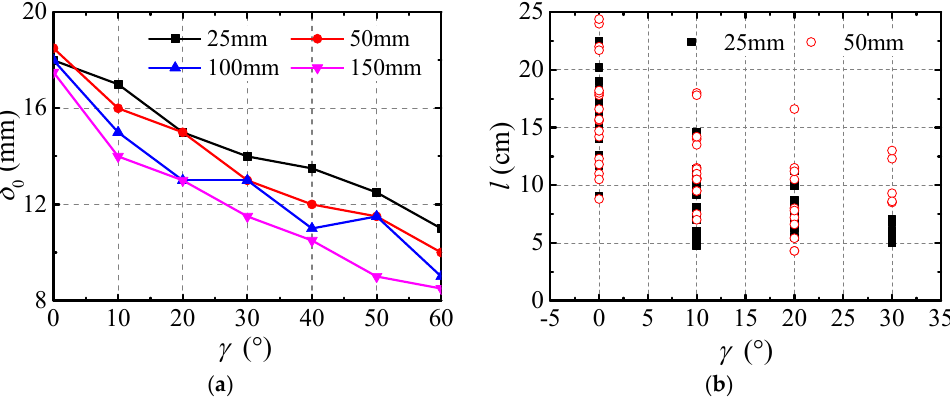
Figure 17. Ice sizes of wind hangers versus γ ( N = 100): ( a ) maximum δ 0 , and ( b ) l.